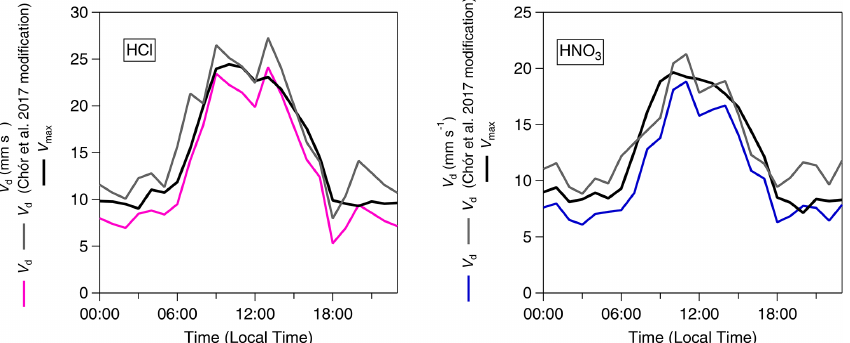
Figure 5. Inorganic trace gas deposition velocities ( V d ) pre- and post-correction values with γ F (Chor et al., 2017) and calculated theoretical maximum deposition velocities ( V max ) for HCl and HNO 3